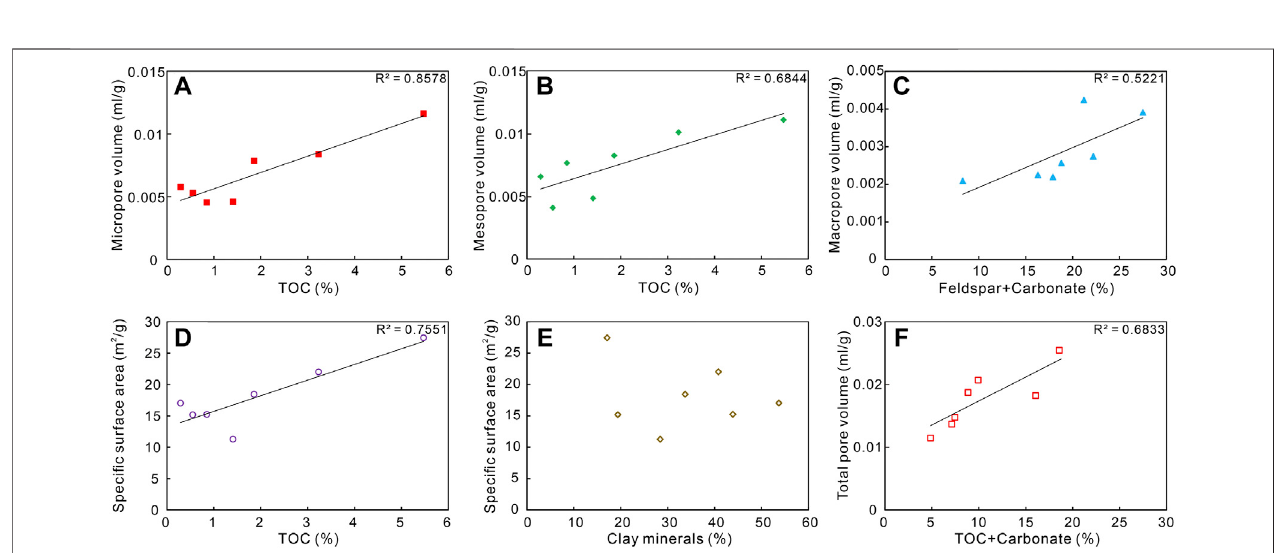
FIGURE 10 | Correlation between pore volume and TOC (A,B) , feldspar+carbonate (C) and TOC +carbonate (F) ; correlation between speci fi c surface area and TOC (D) , and clay minerals (E) .